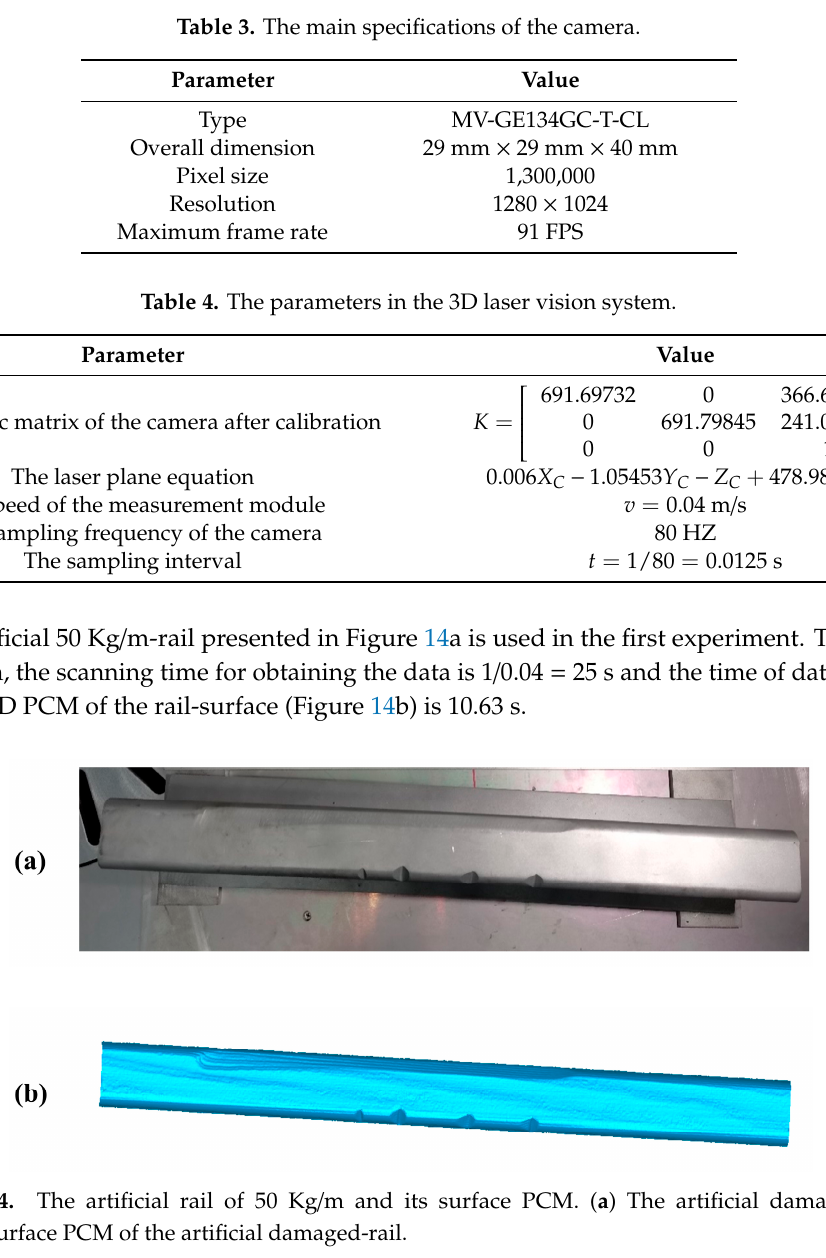
Table 3. The main specifications of the camera.